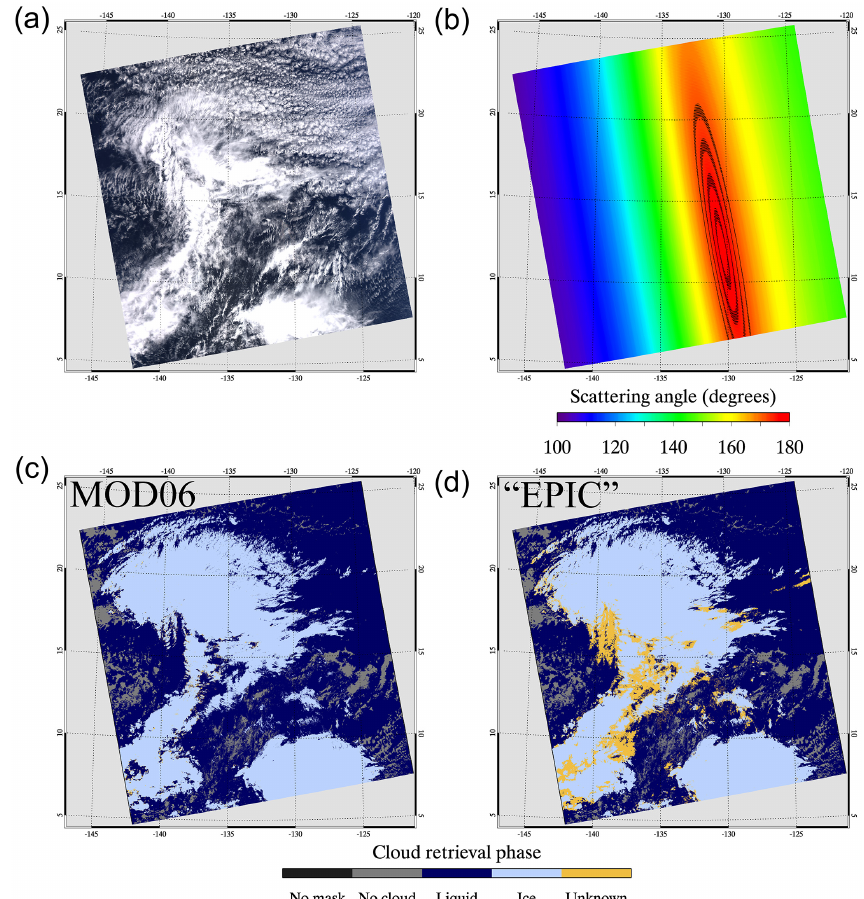
Figure 2. Example Aqua MODIS granule obtained over the eastern Pacific Ocean on 9 April 2005 (22:15UTC); the RGB image and corresponding scattering angle spatial distribution are shown in (a) and (b) , respectively. This granule illustrates the cloud thermodynamic phase differences between the operational MOD06 cloud optical properties algorithm (c) – which uses a variety of SWIR, IR, and spectral CER tests – and an EPIC-style algorithm (d) using only cloud temperature